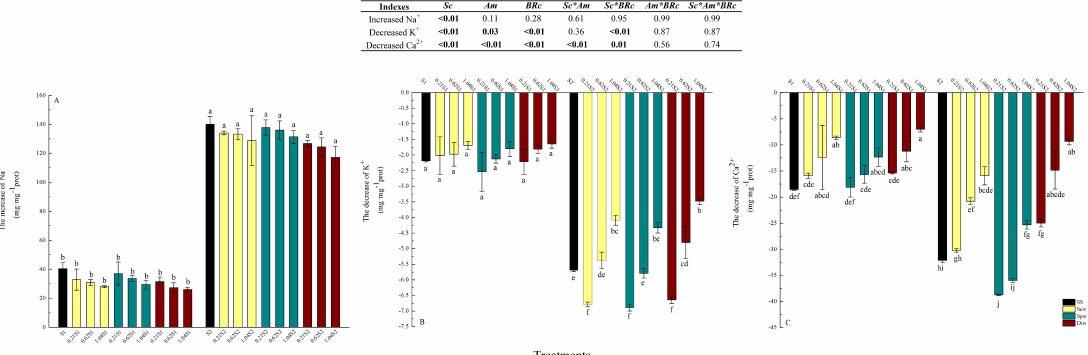
Figure 6. Effects of exogenous 24-epiBL on ( A ) the increase of Na + , ( B ) the decrease of K + , and ( C ) decrease of Ca 2+ in chloroplasts of leaves of black locust seedlings at 100 (SS-S1) or 200 (SS-S2) mM NaCl. Other details as in Figure